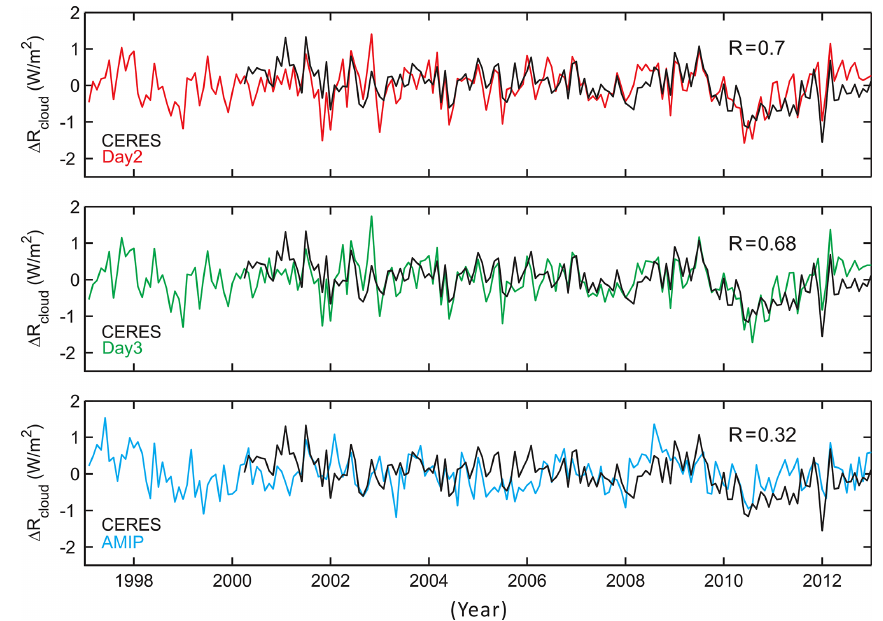
Figure 10. Time series of monthly anomalies of global mean cloud radiative effect from CERES, day 2 and 3 hindcasts, as well as from the AMIP simulation. The correlation coefficient between the model and observation is shown in the upper right portion of each